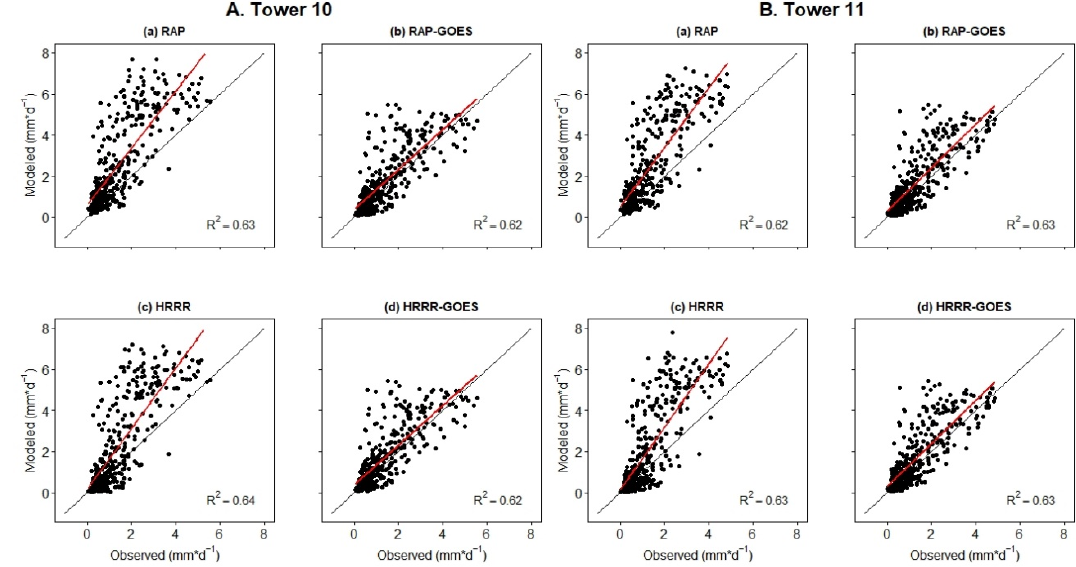
Figure 5. Scatter plots of observed vs. modeled AET in the daily time scale for Tower 10 ( A ) and Tower 11 ( B ) between May 2016 and April 2017. Table 2. Root mean square error (RMSE) and mean bias (MB) results of modeled AET compared to the tower EC-derived AET for hourly and daily data during the study period. Time Intervals